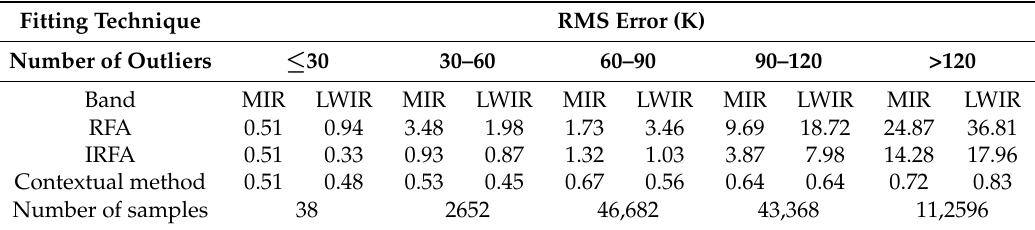
Table 3. Evaluation of relative accuracy of each brightness temperature (BT) fitting process using root mean square (RMS) error in comparision to raw BTs in middle infrared (MIR) and longwave infrared (LWIR).